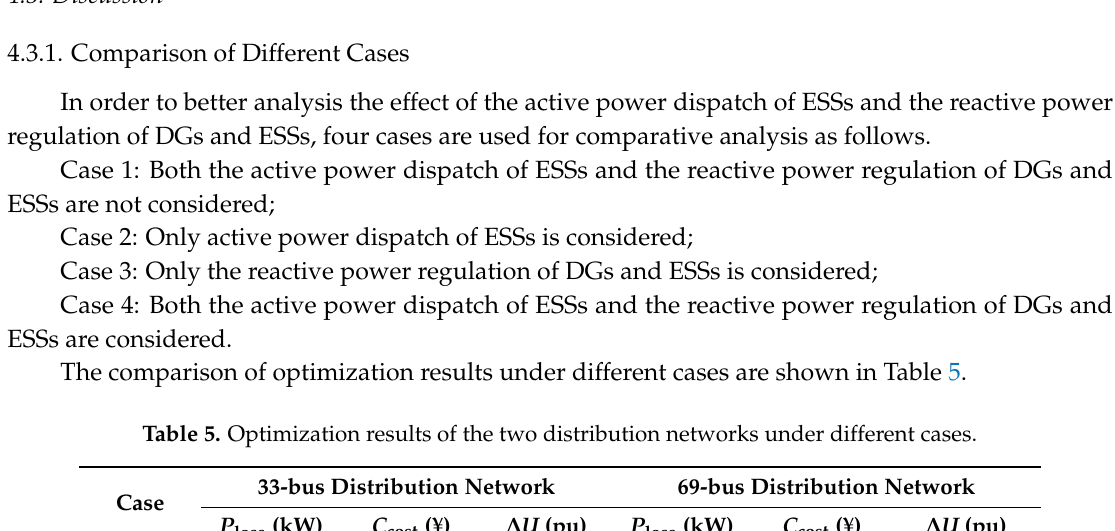
Table 5. Optimization results of the two distribution networks under different